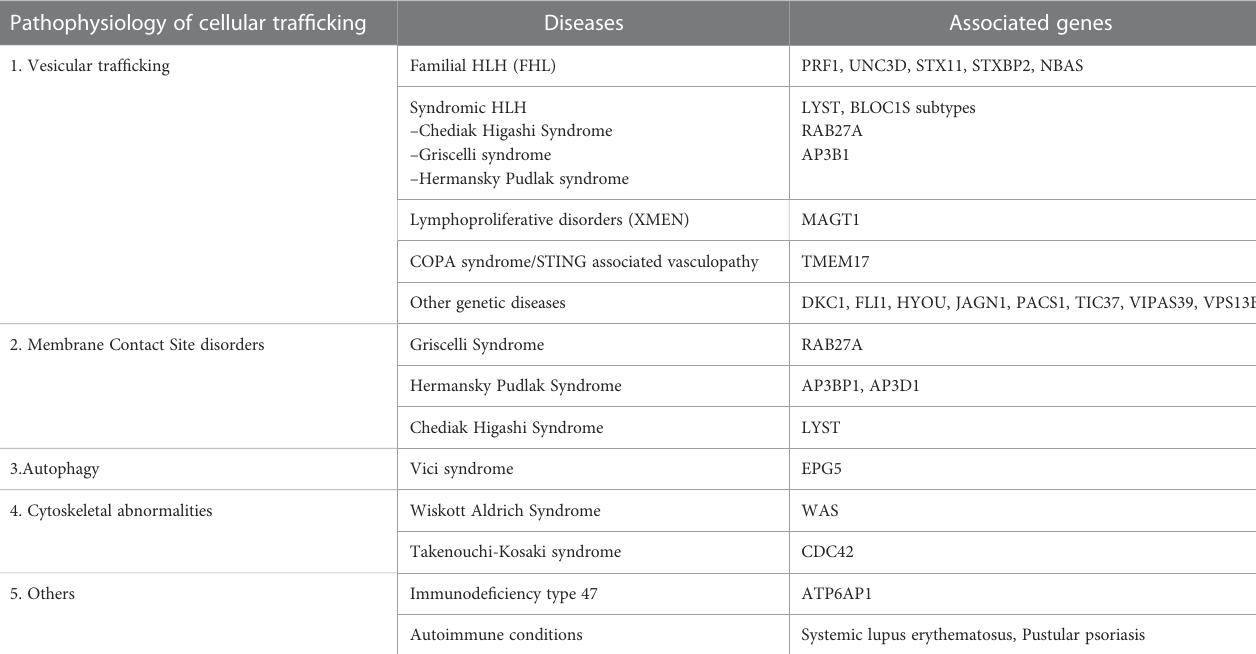
TABLE 1 Pathophysiologic classi fi cation of cellular traf fi cking disorders in lymphocytes. Pathophysiology of cellular traf fi cking